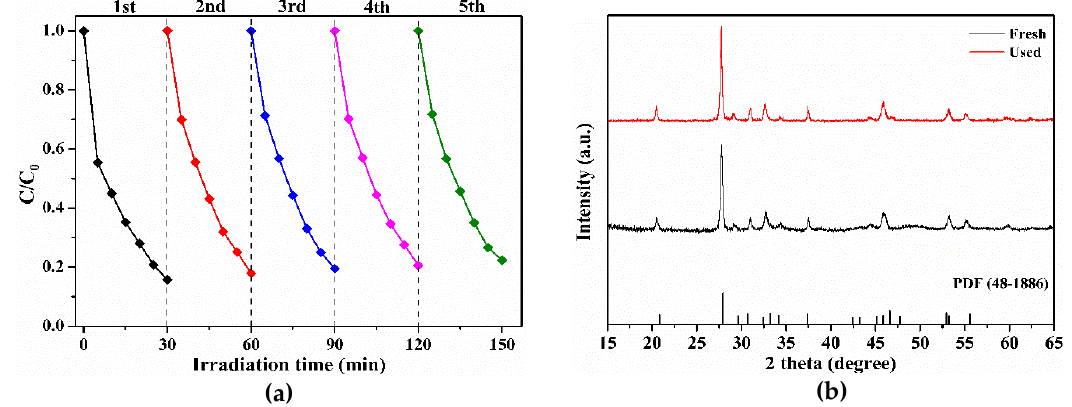
Figure 6. ( a ) Cycling runs for the photocatalytic MB degradation in the presence of CBO-0.5 h; and ( b ) XRD patterns of CuBi 2 O 4 before and after cycle experiment.